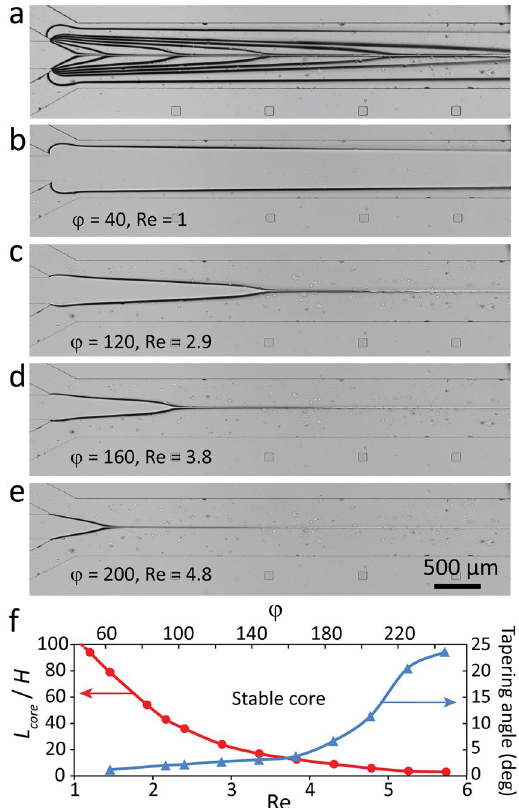
Figure 3. Formation of ‘stable core’ structures obtained by applying glycerol at 1 µ l/min while applying water at varying flow rates of 2 to 240 µ l/min: ( a ) Stacked images obtained at various sheath flow rates, ( b – e ) Individual images obtained at various sheath flows corresponding to Reynolds numbers of 1, 2.9, 3.8 and 4.8, showing the formation of ‘tapered core’ structures followed by ‘viscous thread’ at the downstream of the flow focusing channel, and ( f ) Variations of core length ratio against Reynolds number and sheath/core flow